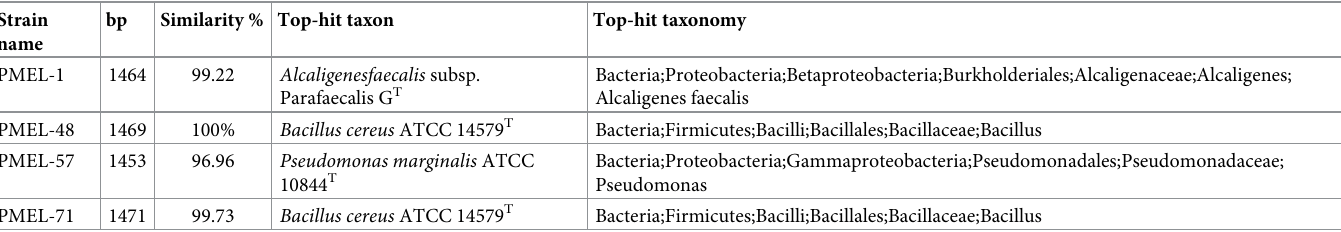
Table 5. Identification of bacterial strains from BLAST on the basis of 16S rRNA gene sequencing and their similarity with type